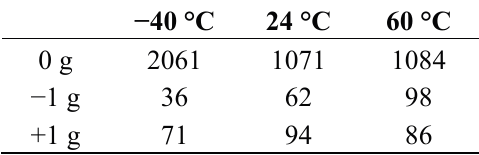
Table 2. Data quantities in different states.